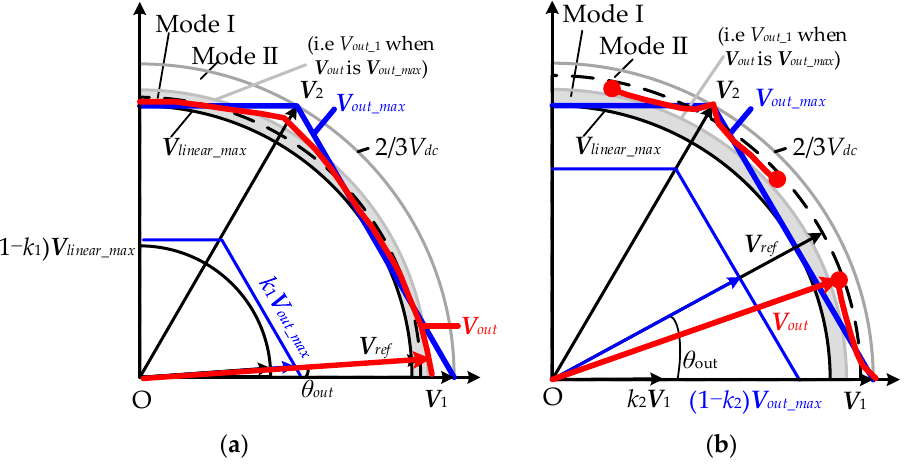
Figure 4. Dual-mode space vector overmodulation based on limit trajectory superposition: ( a ) mode I; ( b ) mode